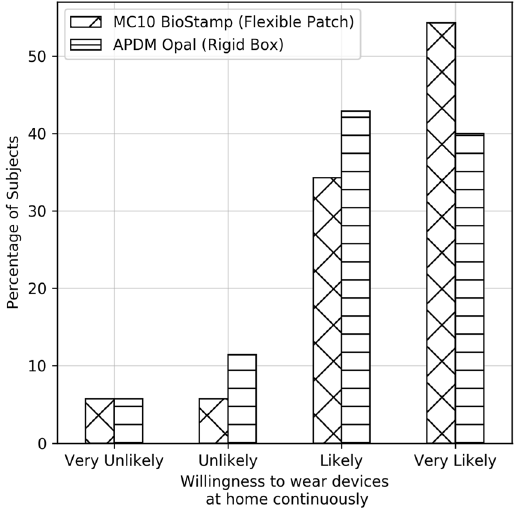
Fig. 6 Willingness of subjects to wear rigid (Opal) or fl exible patch-like (BioStamp) devices continuously at home. A marked preference for a fl exible patch-like device was observed for subjects who were very likely to wear devices continuously at home.